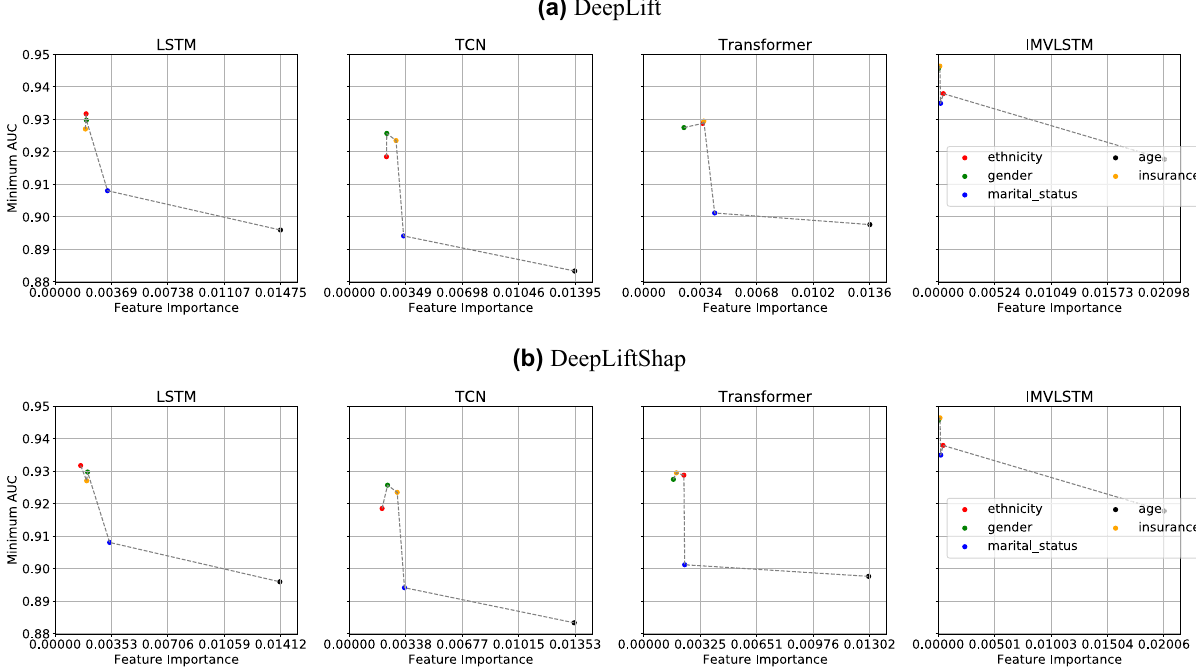
Figure 6. Interactions between Feature Importance from two interpretability approaches and fairness evaluation value Min AUC based on mortality predictions from four